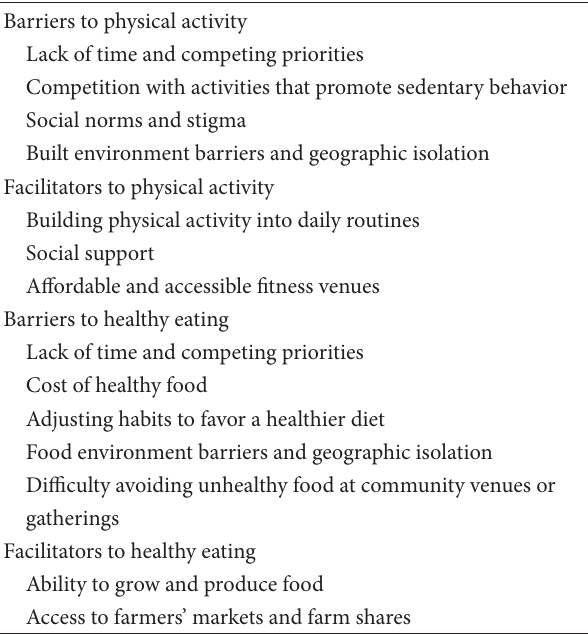
Table 3: Survey responses of focus group participants ( 𝑁 = 95